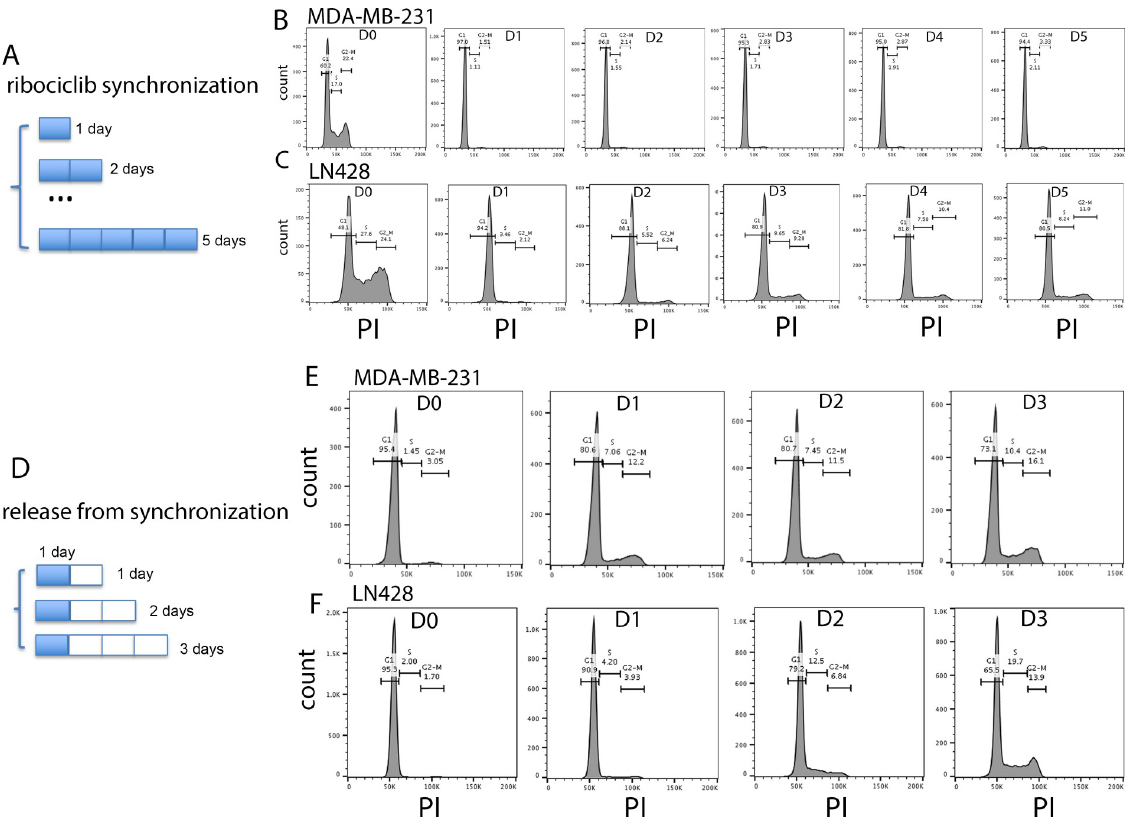
Fig 3. Optimal synchronization-release regime for ribociclib-induced arrest at the G1/S checkpoint. (A) A diagram of G1/S synchronization by ribociclib. (B-C) Representative histograms of cell cycle analysis of MDA-MB-231 (B) and LN428 (C) cancer cell lines treated with ribociclib for 0–5 days (D0-D5). Percentages of cells at different stages of the cell cycle are listed. (D) A diagram of release schedule from ribociclib-induced G1/S arrest synchronization.(E-F) Representative histograms of cell cycle analysis of MDA-MB-231 (B) and LN428 (C) cancer cell lines treated with ribociclib for 1 day followed by ribociclib withdrawal for 0–3 days (D0-D3). Percentages of cells at different stages of the cell cycle are